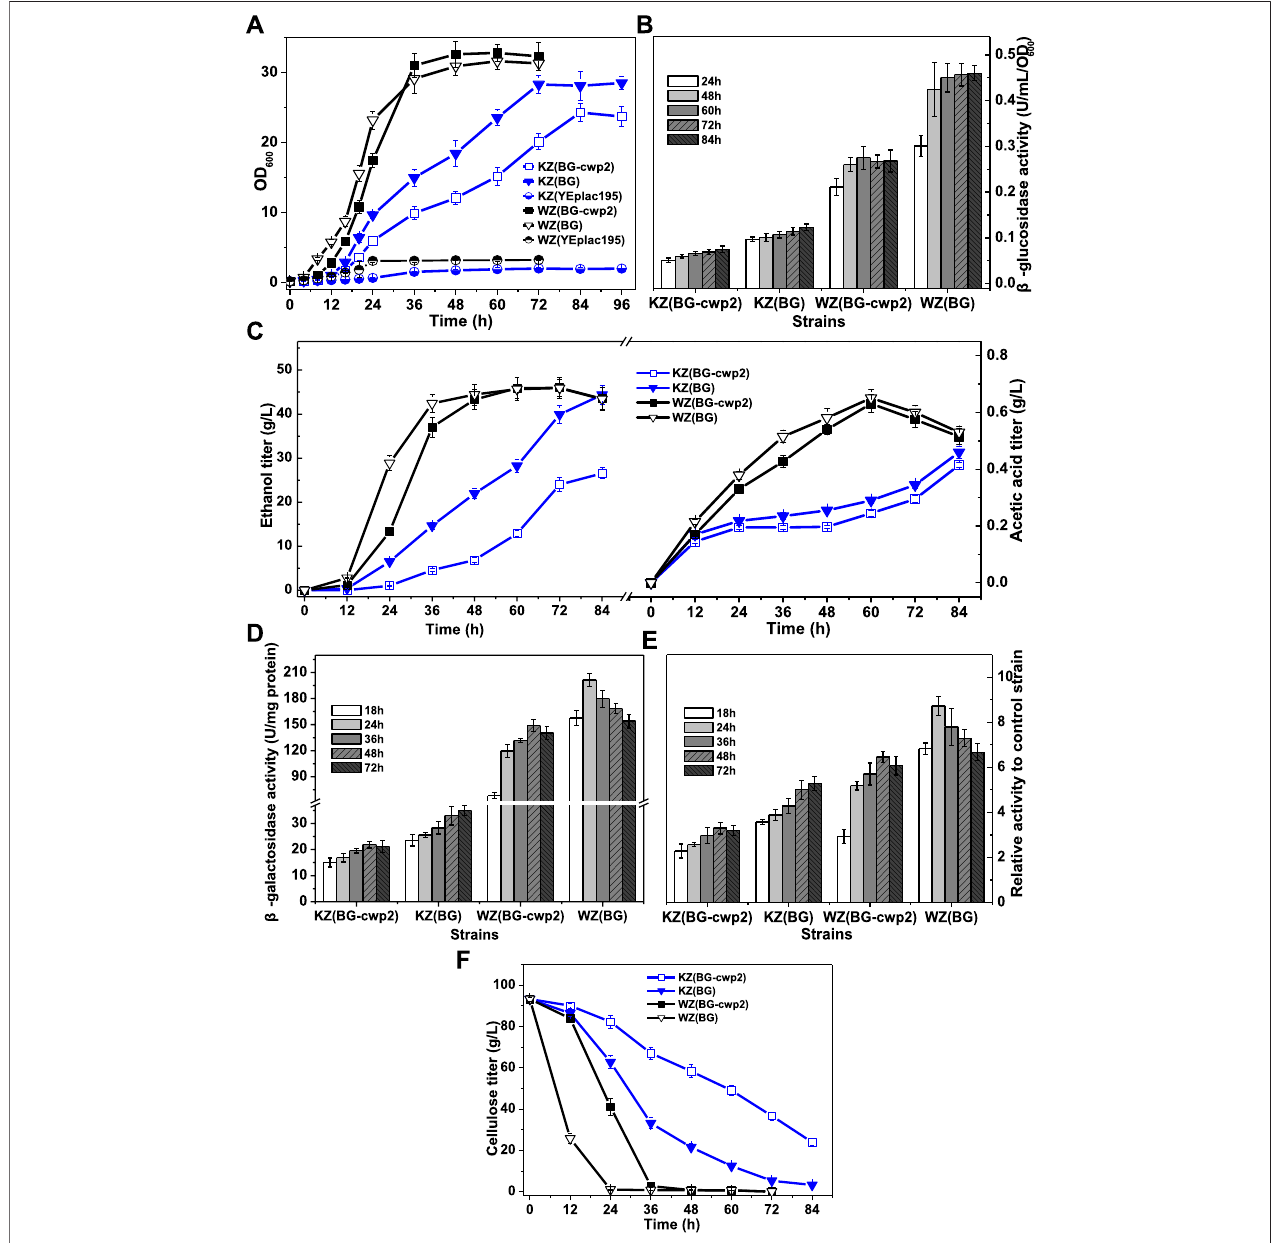
FIGURE 4 | The growth, sugar consumption, β -glucosidase, ethanol and acid production, and β -galactosidase activity of the recombinant strains anaerobically in 10%cellobiose. (A) Thegrowthcurve; (B) total β -glucosidaseactivity(U/ml/OD 600 ),notdetectedforcontrolstrainsWZ(YEplac195)andKZ(YEplac195); (C) ethanoland aceticacidproduction; (D) the β -galactosidaseactivity(U/mgprotein); (E) theratioof β -galactosidaseactivityvalueoffourstrainstothatofcontrolstrainsKZ(YEplac195) and WZ (YEplac195), 6.60 ± 0.85 and 23.1 ± 0.93 U/mg protein, respectively; and (F) the cellobiose curve. The original data was shown in Supplementary Material Table 3